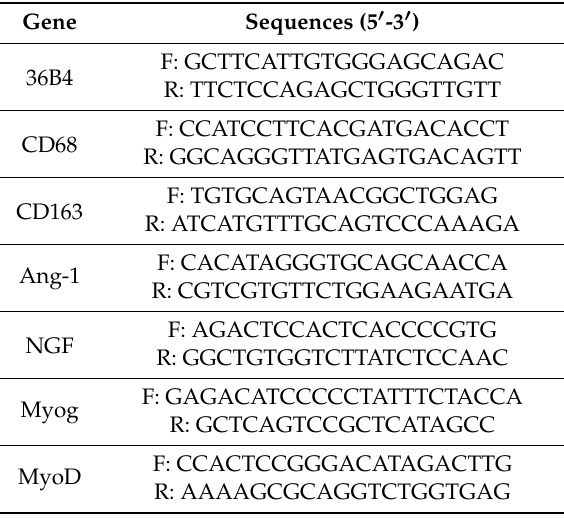
Table 1. Primers used for mRNA